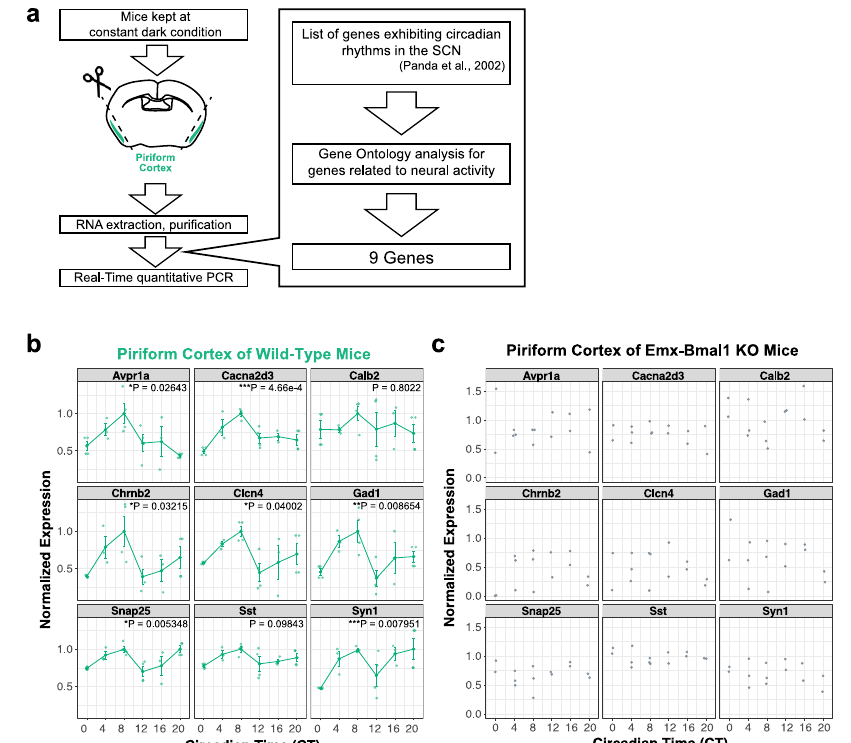
Fig. 6 Genes related to neural activity show circadian rhythmicity in the PC. a Schematic illustration of real-time quantitative PCR. Mice were kept in 12-h Light/Dark condition for at least 3 weeks. Prior to sacri fi ce, mice underwent a constant dark condition, and PC and SCN were dissected for and RNA extraction, puri fi cation for real-time quantitative PCR. b Relative mRNA expression of Avpr1a, Cacna2d3, Calb2, Chrnb2, Clcn4, Gad1, Snap25, Sst, Syn1 mRNA levels in the PC of wild-type mice. N = 4, 3, 4, 4, 3, 4 for CT0, CT4, CT8, CT12, CT16, CT20, respectively. One-way ANOVA with Bonferroni correction. Error bars indicate standard error. c Relative mRNA expression of Avpr1a, Cacna2d3, Calb2, Chrnb2, Clcn4, Gad1, Snap25, Sst, Syn1 mRNA levels in the PC of Emx1-Bmal1 KO mice. N = 2, 3, 3, 2, 2, 2 for CT0, CT4, CT8, CT12, CT16, CT20,